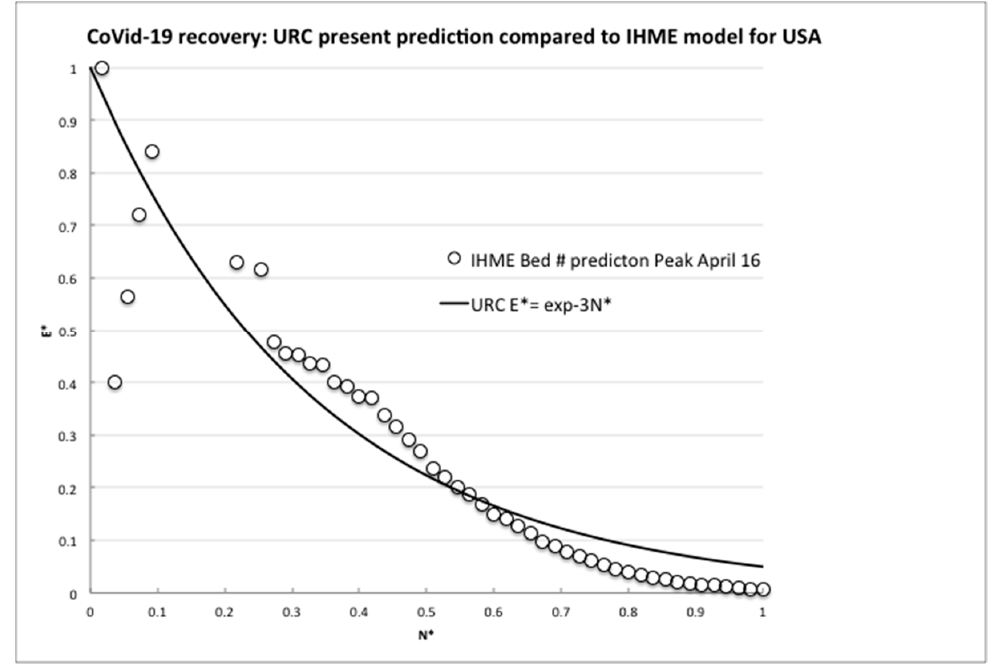
Figure 3. Comparison of the universal recovery curve (URC) to the model predictions of required hospital beds by IHME.